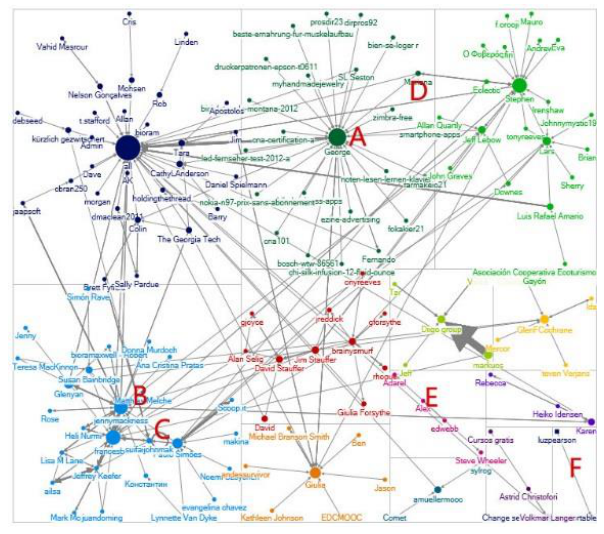
Figure 5. The structure of the social network in the first week from blog based interaction.